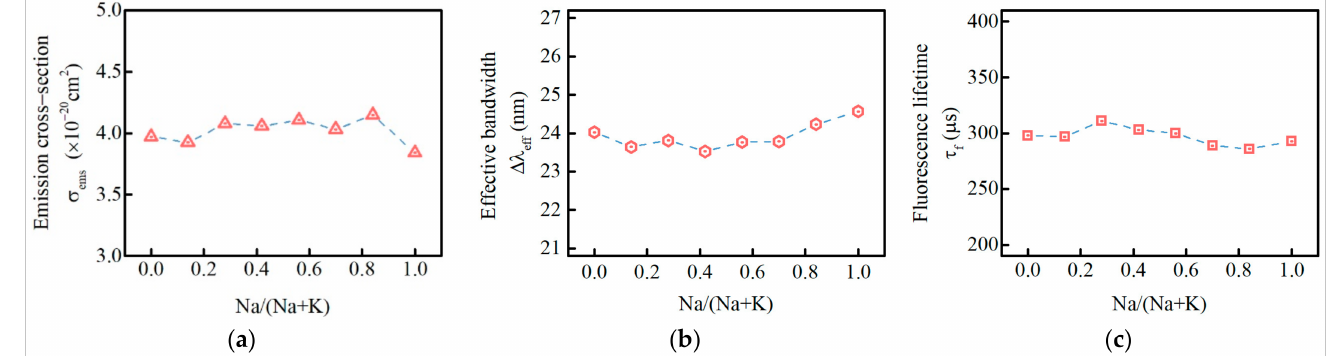
Figure 9. ( a ) Stimulated emission cross − section ( σ ems ); ( b ) effective bandwidth( ∆ λ eff ); ( c ) fluores- cence lifetime ( τ f ) of the Nd 3+ ions at 1053 nm in PKNi glass with different Na/(Na+K)